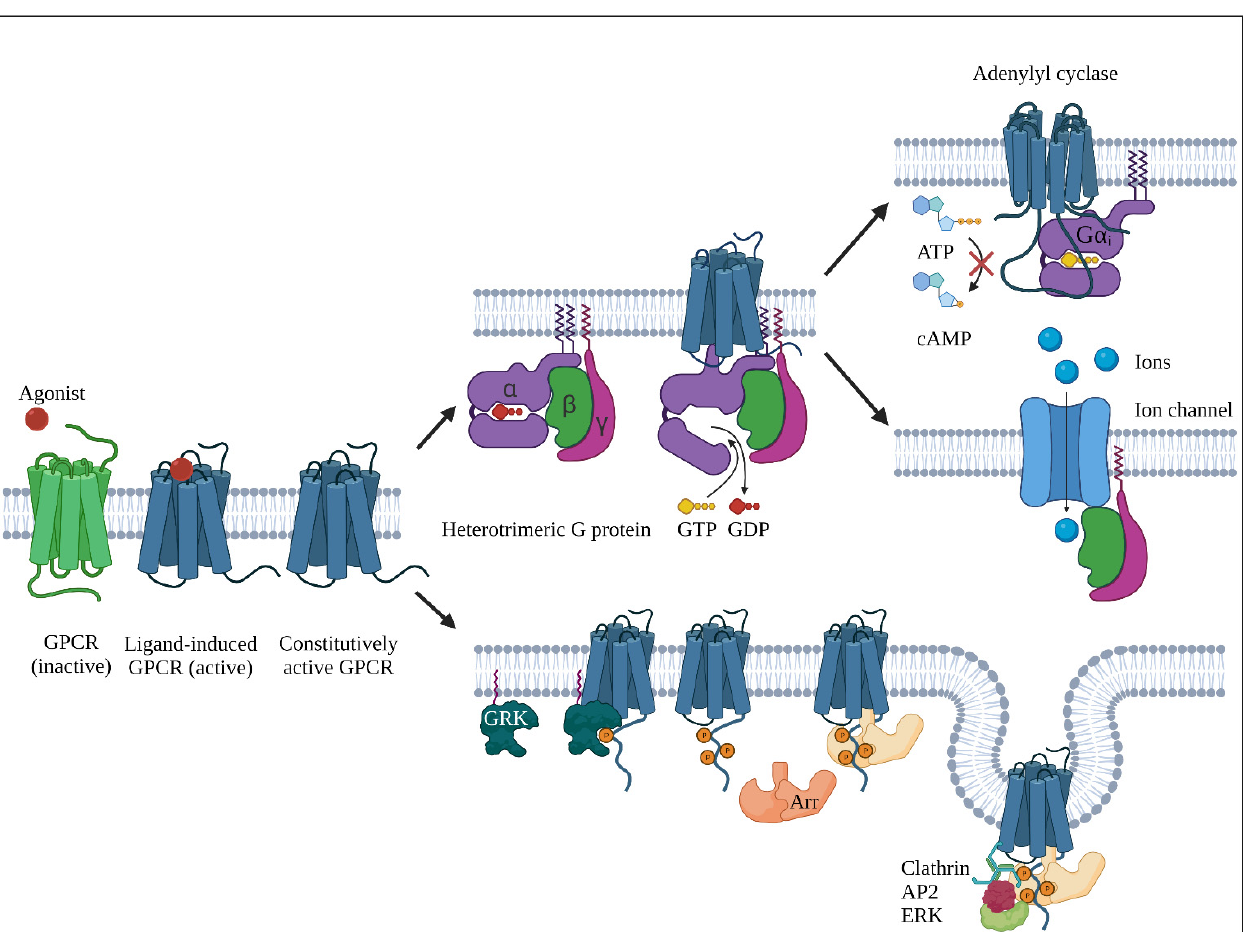
Figure 3. Summary of GPCR activity of constitutively active GPCRs or following binding of an agonist to a receptor. Top , the classical G protein pathway. GTP for GDP exchange in the G protein α subunit results in dissociation and modulation of downstream effectors such as G α i inhibition of adenylyl cyclase and G βγ activation of ion channels. Bottom , arrestin-associated signaling via activated GPCRs. Phosphorylation of the cytosolic C-terminus by a G protein–coupled receptor kinase (GRK) leads to arrestin (Arr) recruitment and activation. This promotes receptor endocytosis via interactions with the clathrin adaptor protein 2 (AP2) complex and activation of extracellular signal-regulated kinase (ERK). Created with BioRender.com. Inspired by Weis et al. [117] and Komolov et al. [126].